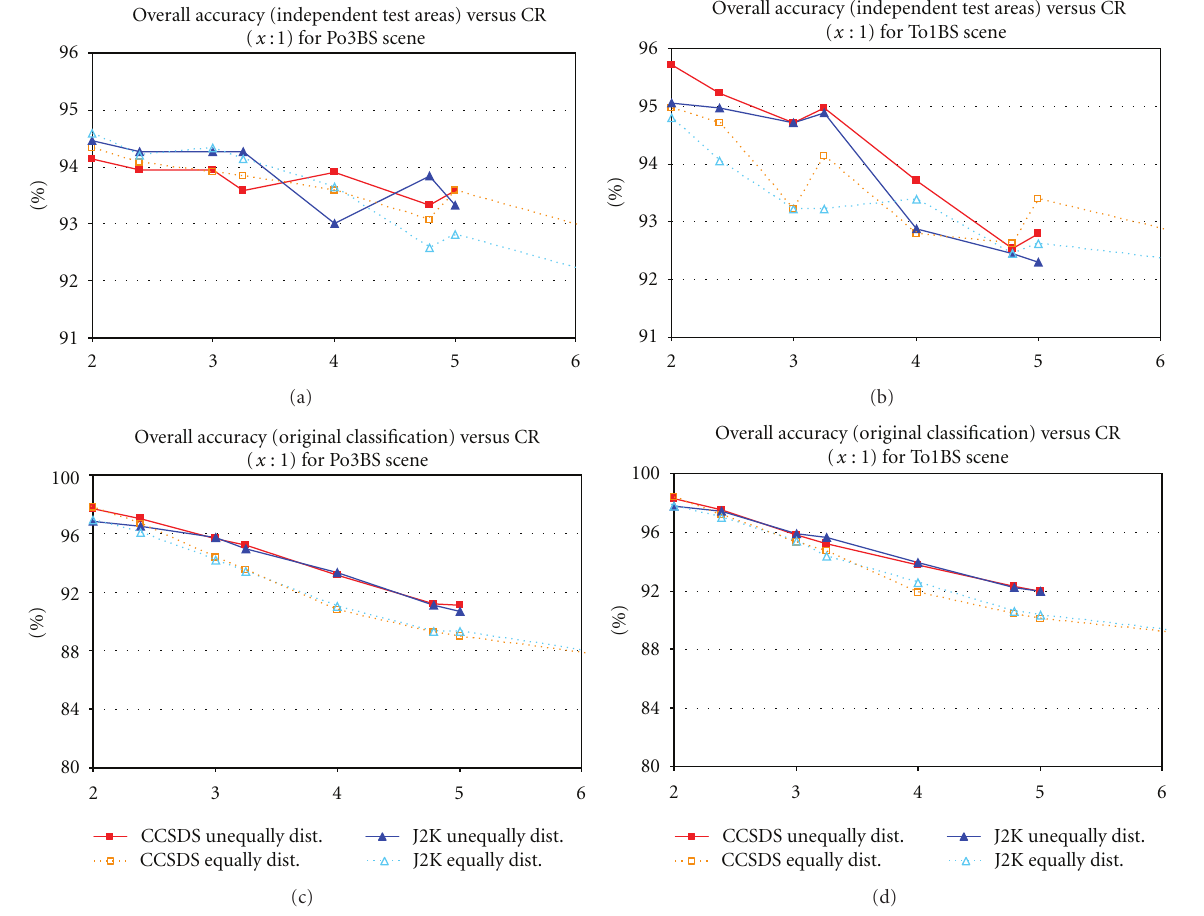
Figure 7: Overall accuracy (in %) of classifications in relation to the compression ratio (CR, expressed as x :1, e.g., 5: 1) of the CCSDS and JPEG 2000 compression standards for the “Les Landes-P03BS” and “Toulouse-Urban-T01BS” scenes. As ground truth, the graphics (a and b) use independent test areas and the graphics (c and d) use the classification obtained without